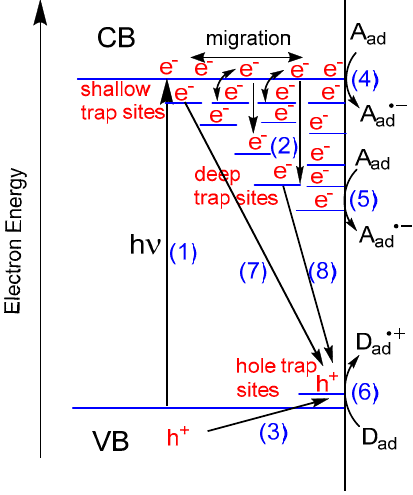
Figure 1. Schematic model of the earlier stage of photocatalysis in the anatase titanium dioxide (TiO 2